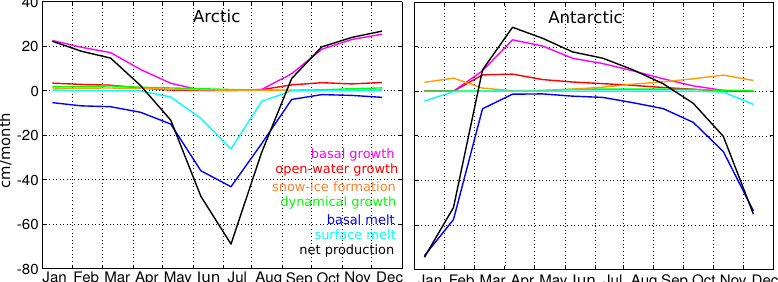
Figure 6. Simulated mean seasonal cycles of the different ice mass balance processes in the ORCA2-LIM3 simulation: Arctic (left panel) and Antarctic (right panel). Ice grows from the base (magenta), in open water (red), by snow–ice formation (orange) or by freezing of sea water trapped in the ridges (green). Ice melts at the base (blue) and surface (cyan). Ice advection is nil here since diagnostics are hemispheric. The black line is the net ice production (i.e. the sum of all the processes). Units are in cmmonth − 1 . Positive and negative values represent creation and destruction of sea ice,